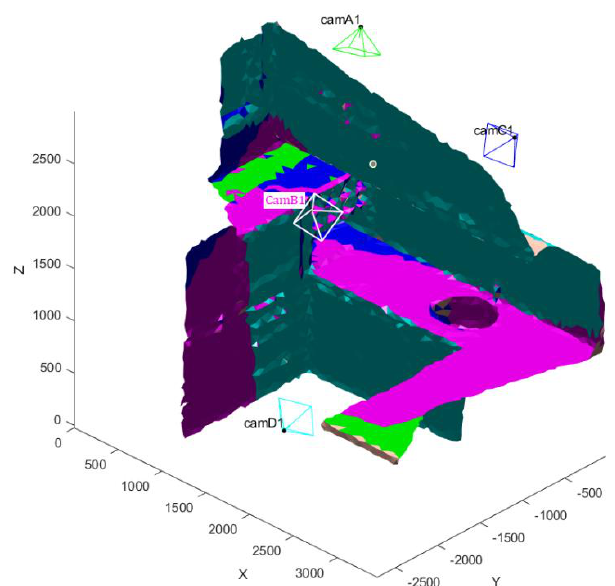
Figure 20. Visibility Map computed on the BlenSor kitchen model with four sensors observing the scene. Triangles observed by the first camera are colored in green; the triangles observed by the second camera are colored in blue; triangles observed by third camera are colored in magenta; triangles observed by the fourth camera are colored in